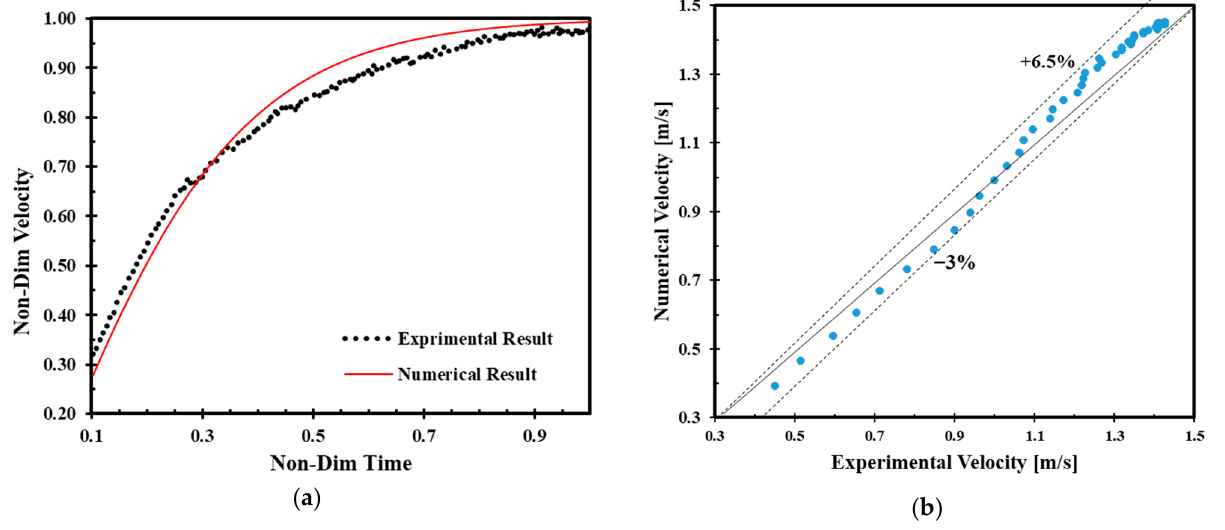
Figure 2. ( a ) Comparison of the numerical and experimental data for a cold settling sphere in the water and ( b ) comparing the result dispersion for the numerical and experimental analysis for the settling sphere (non-dimensional velocity = v / Vt where Vt is terminal velocity).